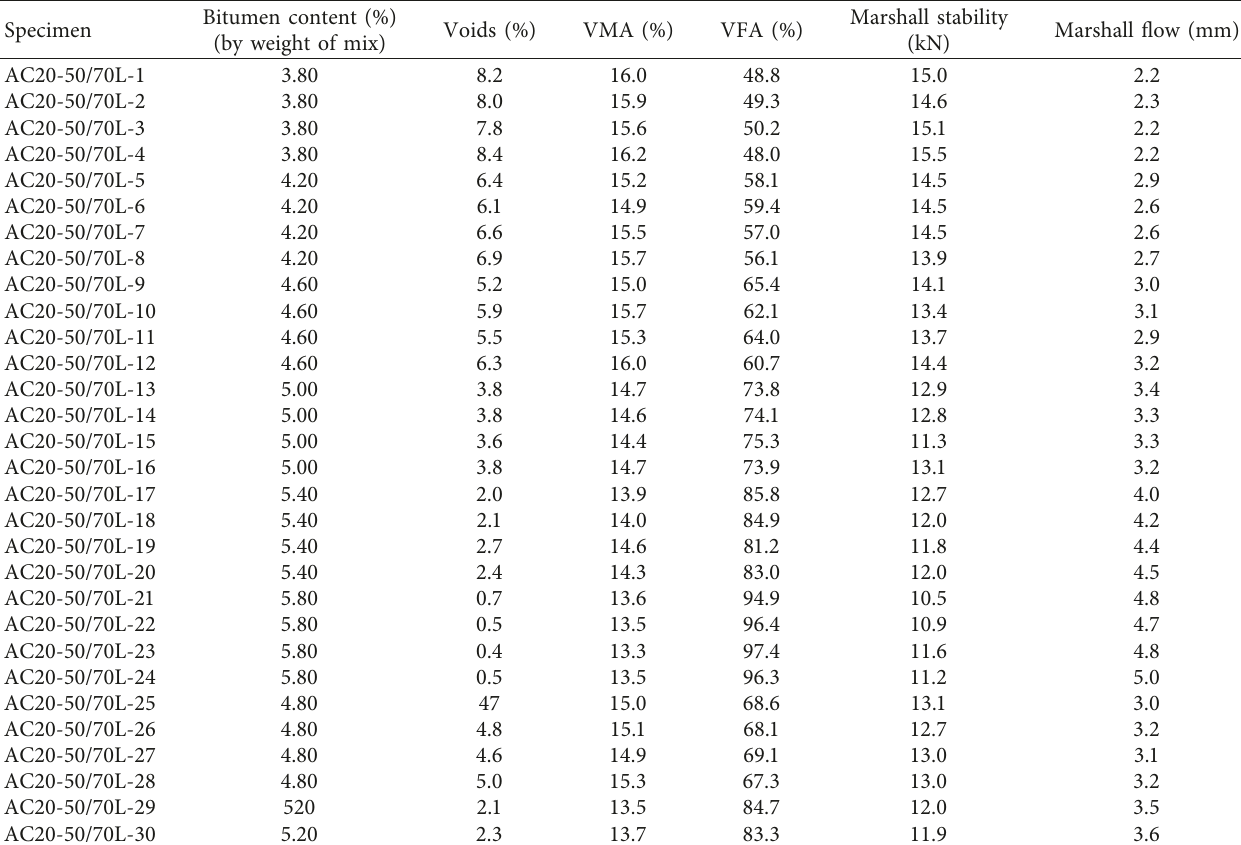
Table 3: Properties of AC20-50/70L specimens.